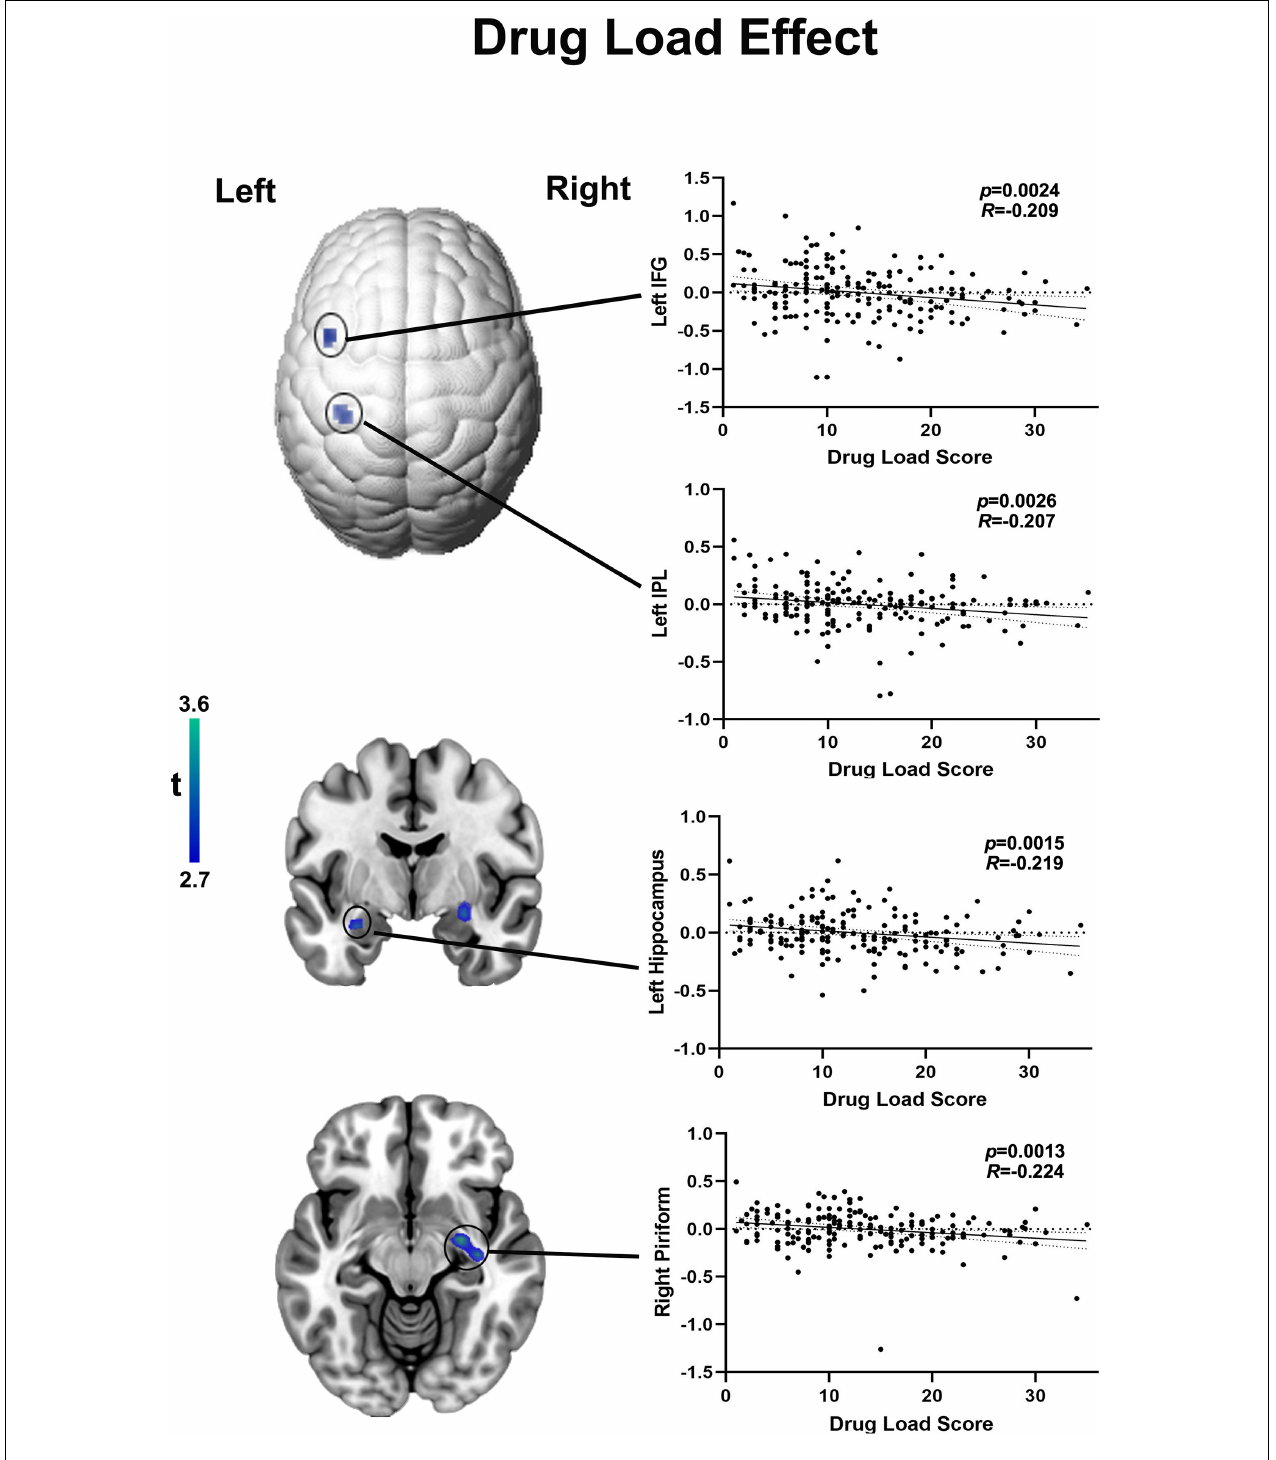
FIGURE 3 | Functional activation in language areas and piriform cortex correlates with drug load of ASMs with moderate cognitive side effects. Cortical changes are demonstrated on a surface-rendered brain template and subcortical changes are demonstrated superimposed on MNI 152 template with a bar chart indicating t score. Among those on moderate ASMs, the drug load score is negatively correlated with functional activation in right piriform cortex left hippocampus, higher drug dosage scores were associated with lower activation of the inferior frontal gyrus (IFG) and left inferior parietal lobule (IPL) at a threshold of P < 0.005 uncorrected, 10